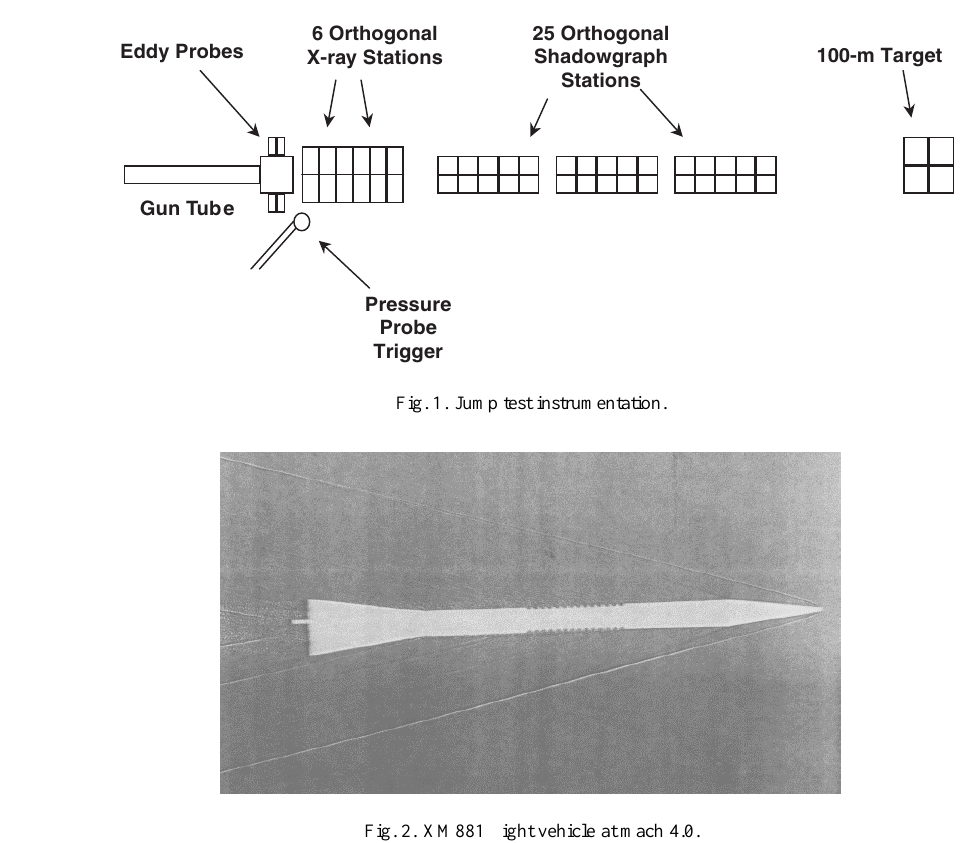
Fig. 2. XM881 flight vehicle at mach